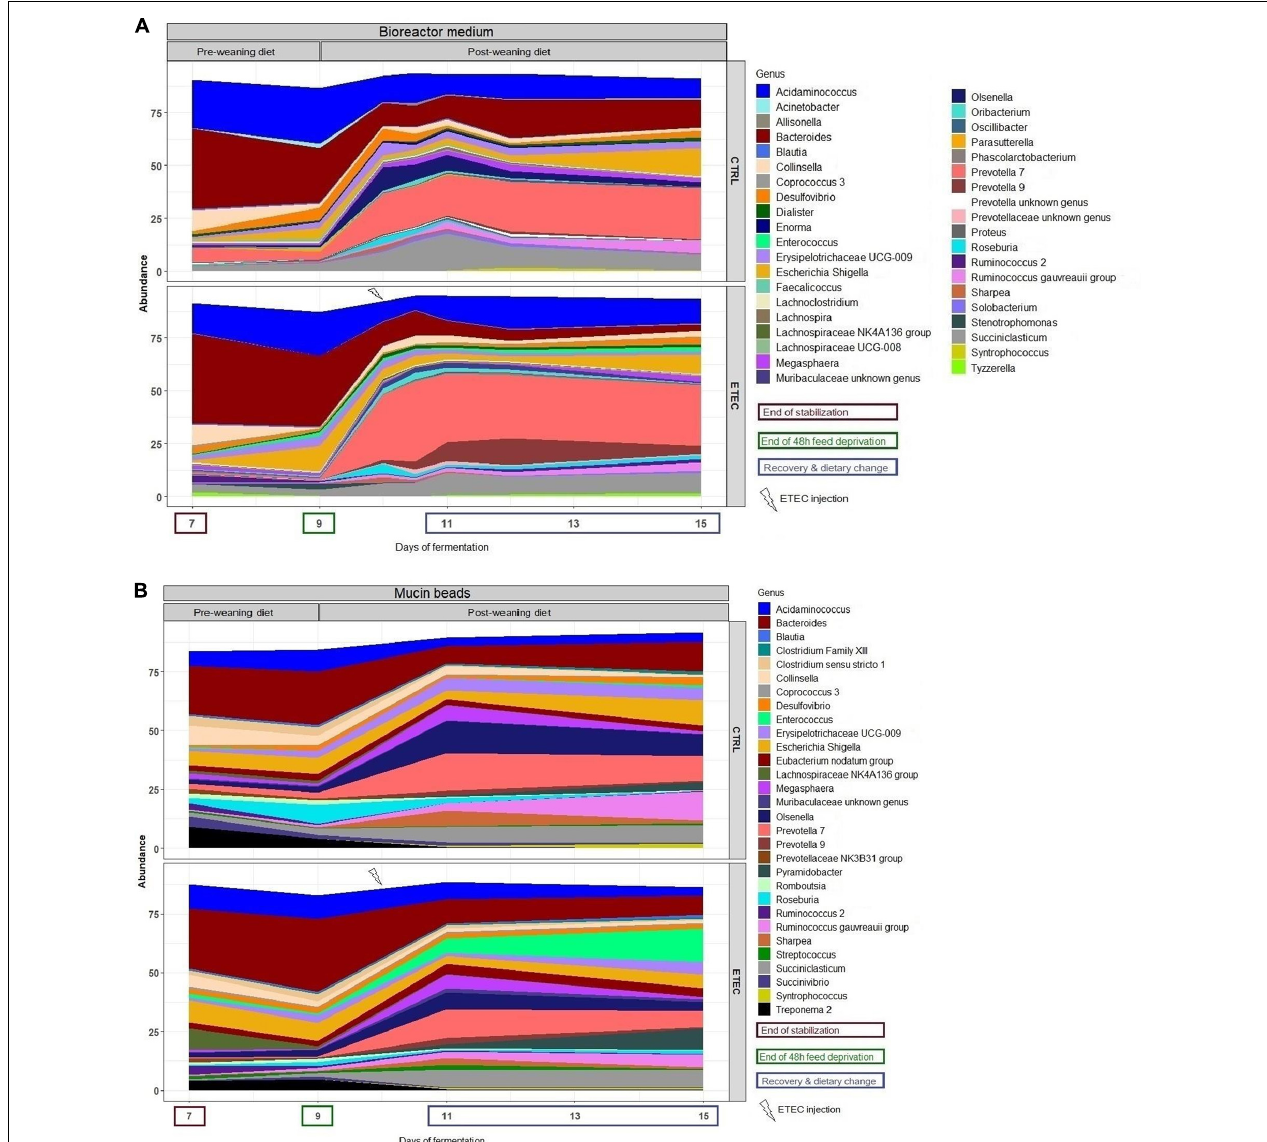
FIGURE 6 | Mean relative abundance of the 30 more abundant bacterial genera in the bioreactor medium (A) and mucin beads (B) of MPigut-IVM in the CTRL and ETEC conditions ( n =